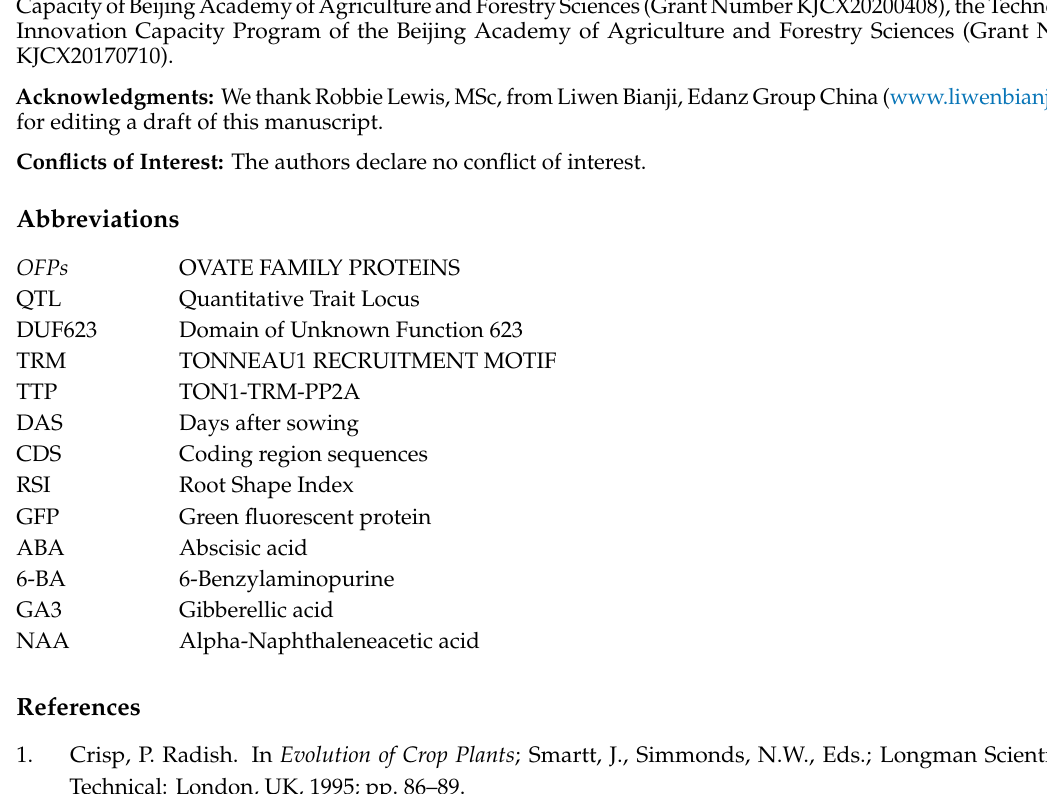
s1. Figure S1. Root shape indexes of GX18-3, GX18-4, GX18-5, GX18-6, GX18-7, and GX18-8. Table S1. Information on the 40 putative RsOFPs . Table S2. Primers used in this